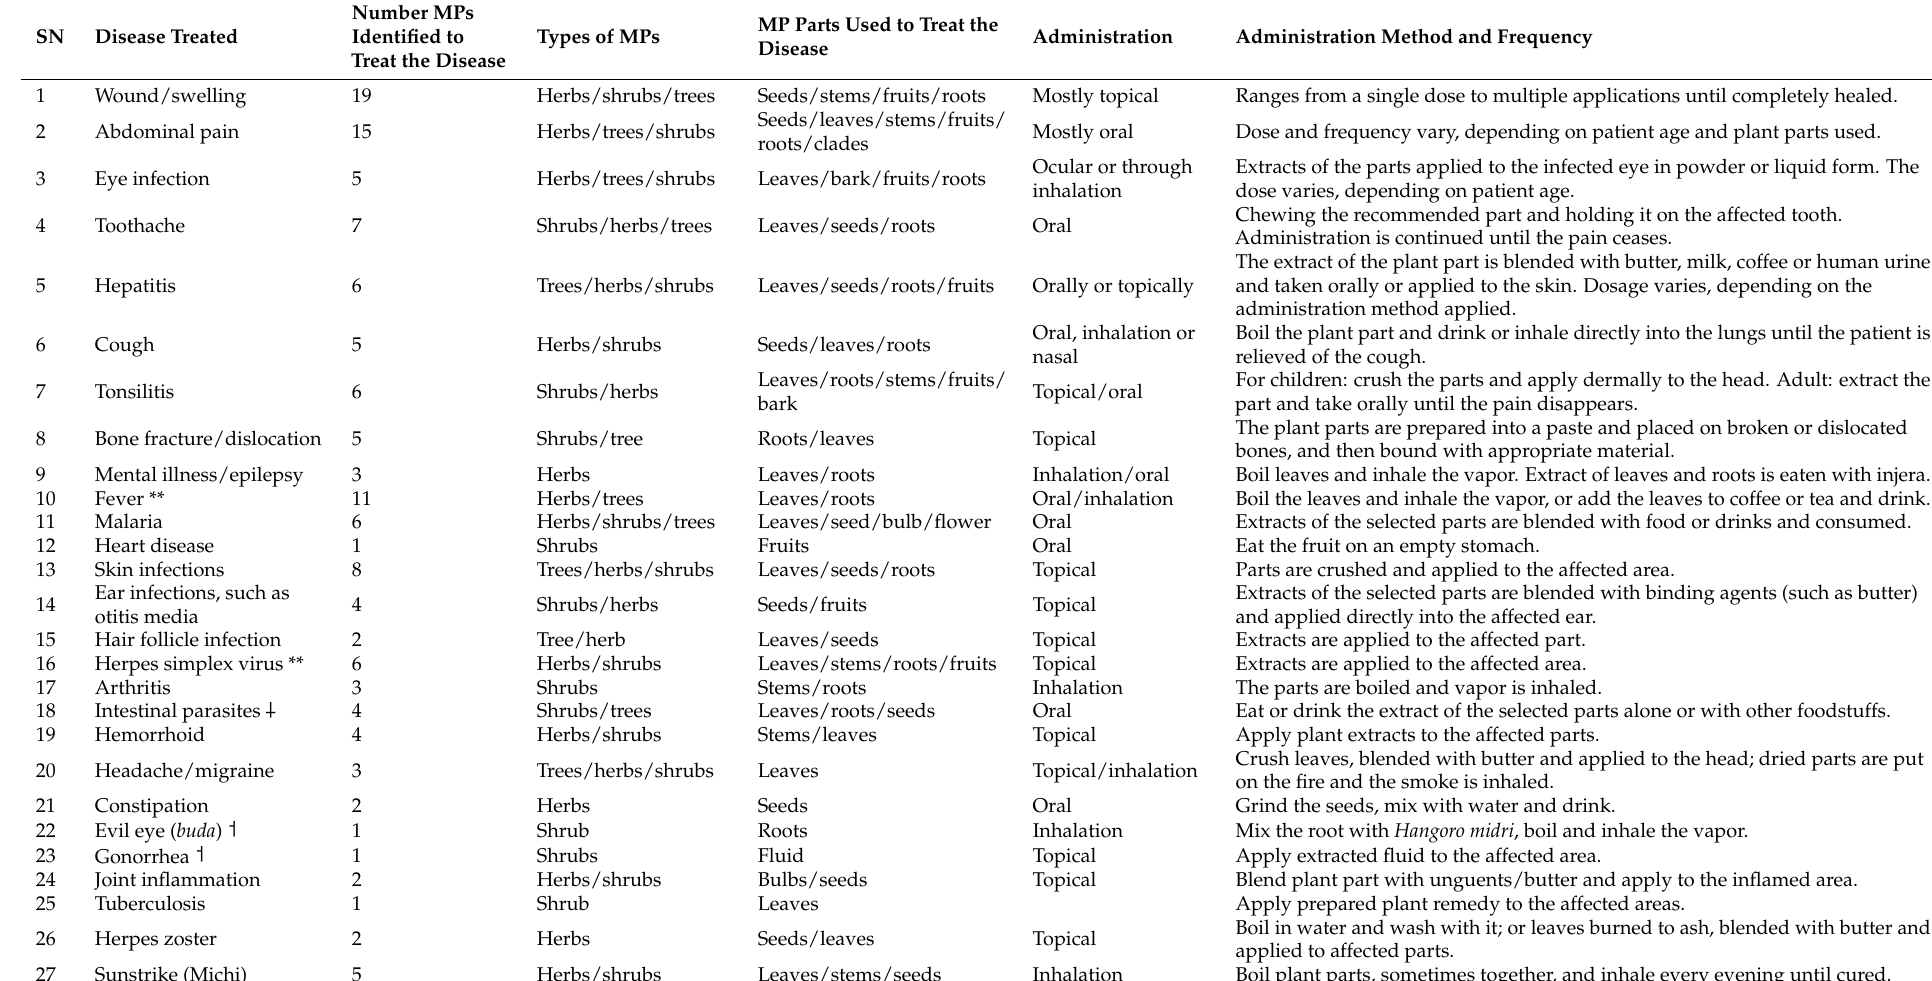
Table 1. Identified plants/shrubs/trees used to treat human diseases in Tigray and the associated indigenous knowledge on the plant parts used, administration type and frequency of administration (source: own data).